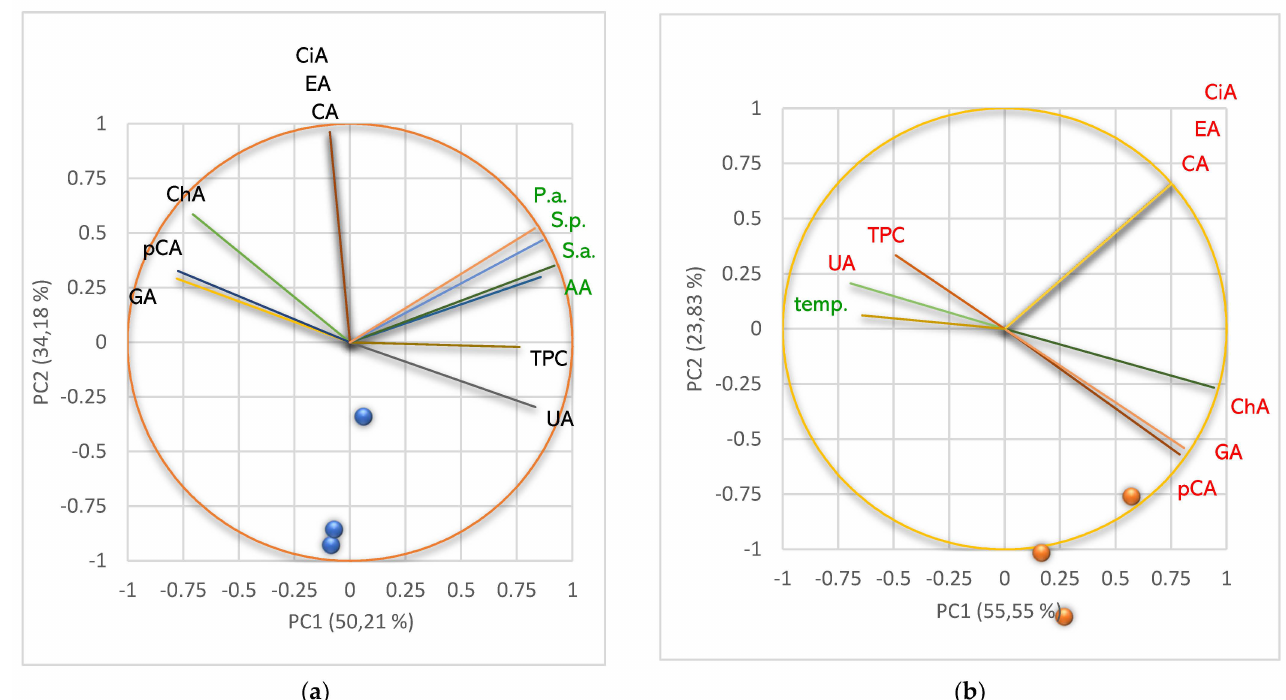
Figure 6. Principal component analysis (PCA): PCA-Correlation circle between phenolic metabolites and bioactivities of U. barbata extracts ( a ); PCA-Correlation circle between phenolic metabolites and extraction temperature ( b ). pCA— p -coumaric acid, ChA—chlorogenic acid, CA—caffeic